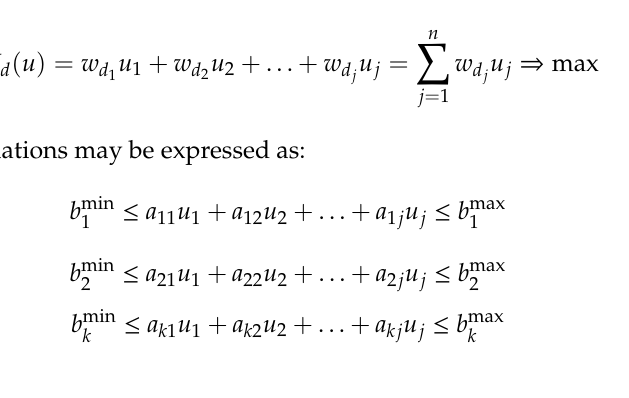
Algorithmic Model for the Optimization of the Production Process of Hybrid Fuel Components—Thread